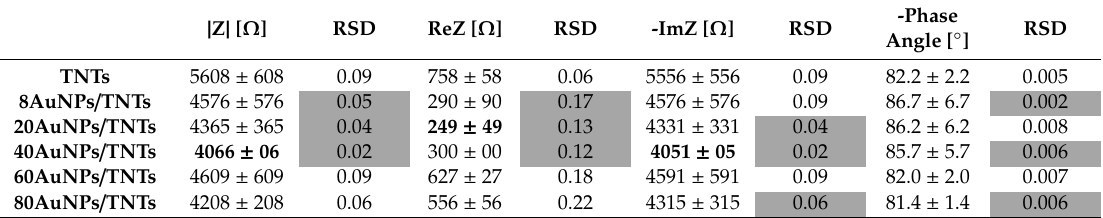
—the lowest value of RSD. Table A2. Table of mean values of phase angle and |Z| recorded in the lowest frequency (0.1 Hz), resistance ReZ and –ImZ with SD and RSD measured for annealed TNT arrays after deposition of AuNPs using CV method for di ff erent number of cycles (8, 20, 40) and concentration of HAuCl 4 0.1 mM, 1 mM, 5 mM, 10 mM.